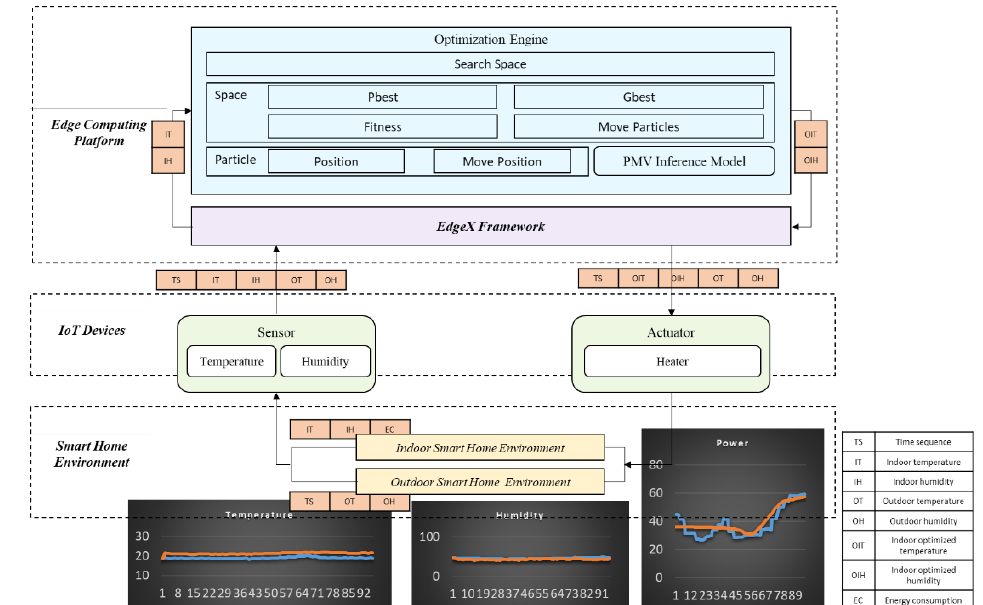
Figure 5. Developed Structure of Smart Home Environment Optimization Scheme based on Edge Computing Platform.